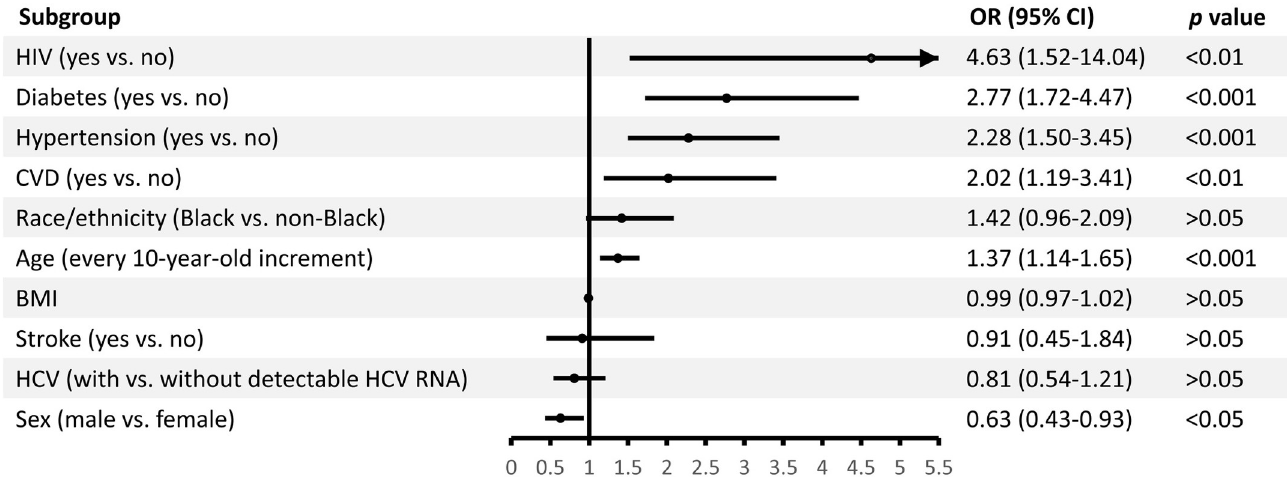
Fig 3. No difference in kidney disease risk between those with and without detectable hepatitis C virus (HCV) ribonucleic acid (RNA). Variables in the multivariable logistic regression model include age, sex, self-identified race/ethnicity (Blacks or non-Blacks), body mass index (BMI), diabetes, hypertension, cardiovascular disease (CVD), previous stroke, HCV infection tatus (detectable or undetectable HCV RNA), and human immunodeficiency virus (HIV) infection.